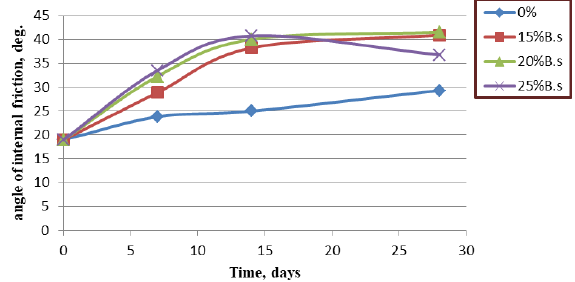
Figure 5: The effect of bacterial solution (B.s) with time on the internal friction